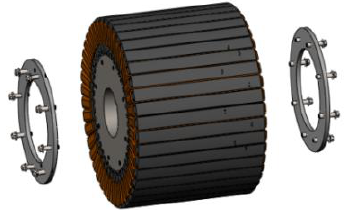
Figure 8. Multi-module spliced type stator structure.